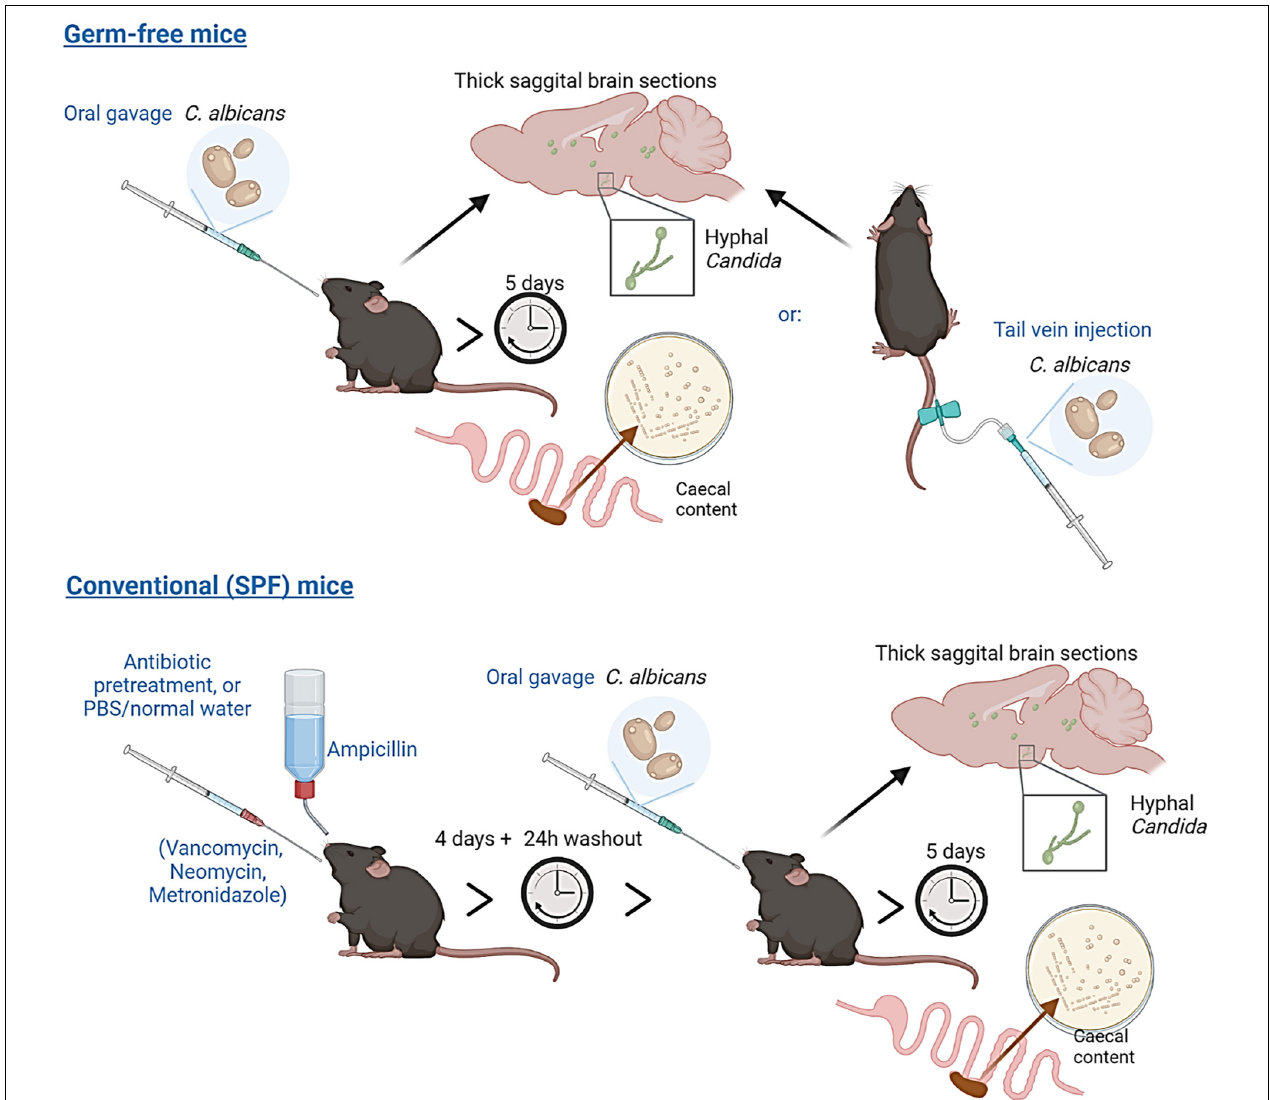
FIGURE 1 | Experimental overview. Germ-free C57BL/6 mice were administered Candida albicans (strain NYCY 3115) either by oral gavage or tail vein injection. Conventional (Specific-Pathogen-Free, SPF) mice were pre-treated with a broad-spectrum antibiotic cocktail (or delivered PBS/normal drinking water) for 5 days, prior to delivery of Candida albicans by oral gavage. Caecal content and brain tissues from all mice were collected five days post C. albicans delivery to assess colonisation and dissemination to the